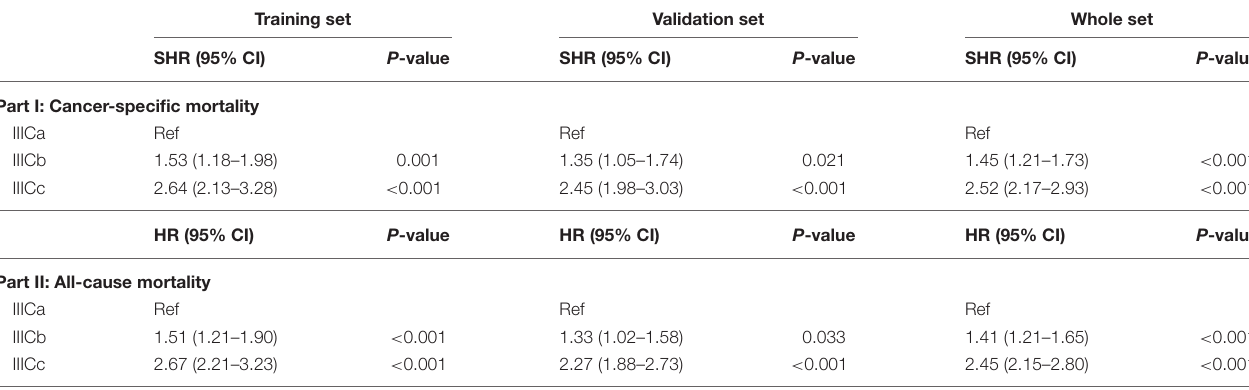
TABLE 3 | Multivariate analysis of cancer-specific and all-cause mortality a . Training set Validation set Whole set SHR (95% CI) P -value SHR (95% CI) P -value SHR (95% CI) P